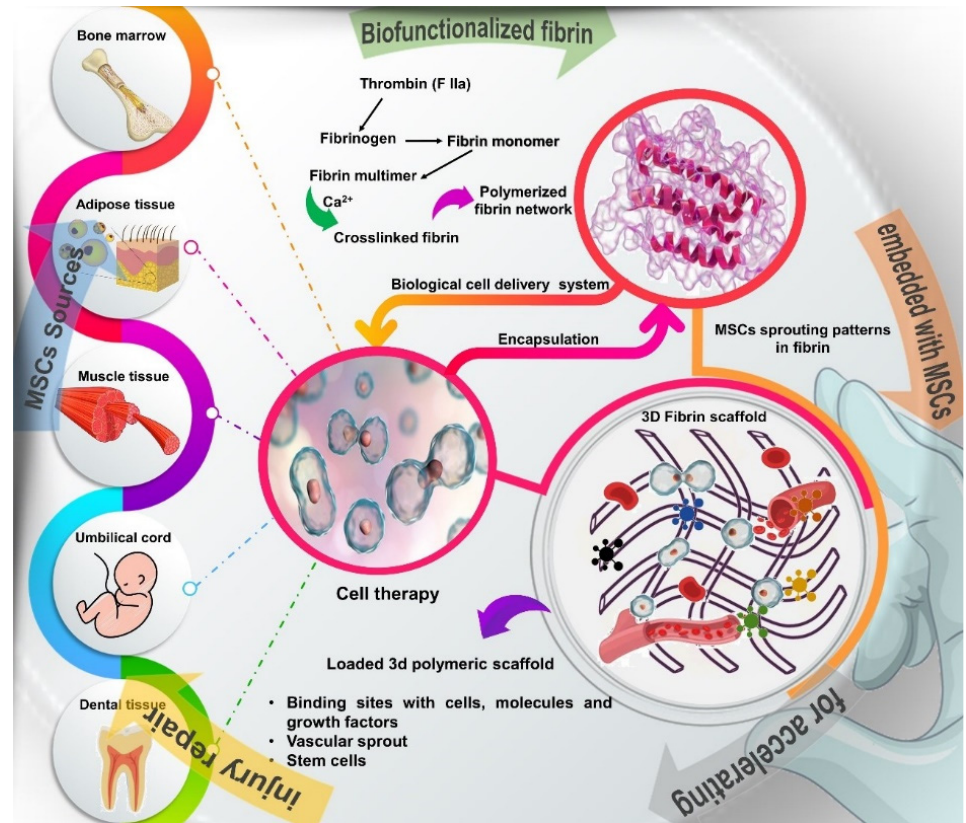
Figure 1. Schematic overview of the different sources of stem cells, such as bone marrow, adipose tissue, muscle, tendons, umbilical cord, and dental tissue and description of how to obtain the fibrin network, a natural polymer formed by the combination of thrombin and fibrinogen, which are components of the blood coagulation system. Fibrin glue provides a 3D bioactive matrix that favors cell adhesion, viability, proliferation and differentiation, in addition to containing numerous binding sites with cells, molecules and growth factors that act in the tissue regeneration process.